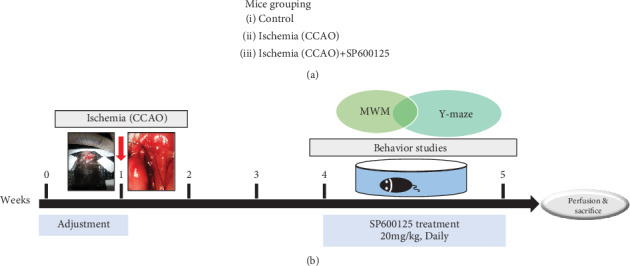
(a) Indicating mice grouping i.e. (1.) Control (2.) Ischemic (3.) Ischemia+SP600125. (b) Showing study plan for the current research work.